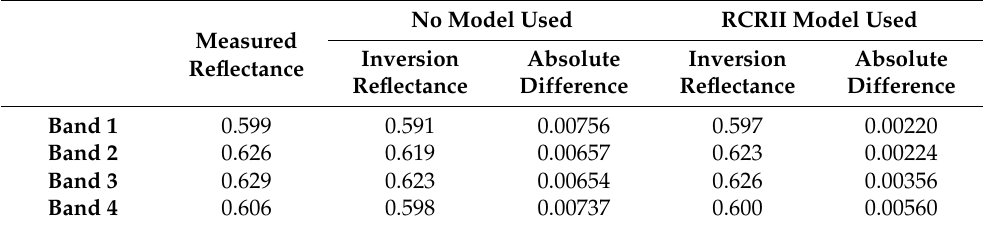
Table 1. Comparison of the 60% target reflectance